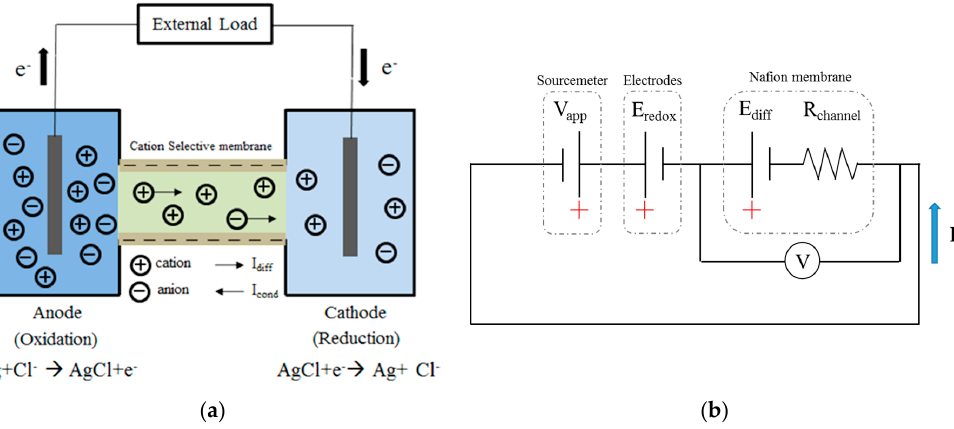
Figure 3. ( a ) Schematic illustration of the RED process in the cation-selective channel; and ( b ) the equivalent electrical circuit of the experimental setup. equivalent electrical circuit of the experimental